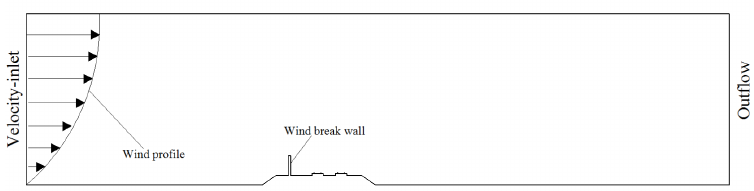
Figure 3. Configuration of numerical simulation. The dimensional channel size of the numerical simulation was consistent with the working section of the wind